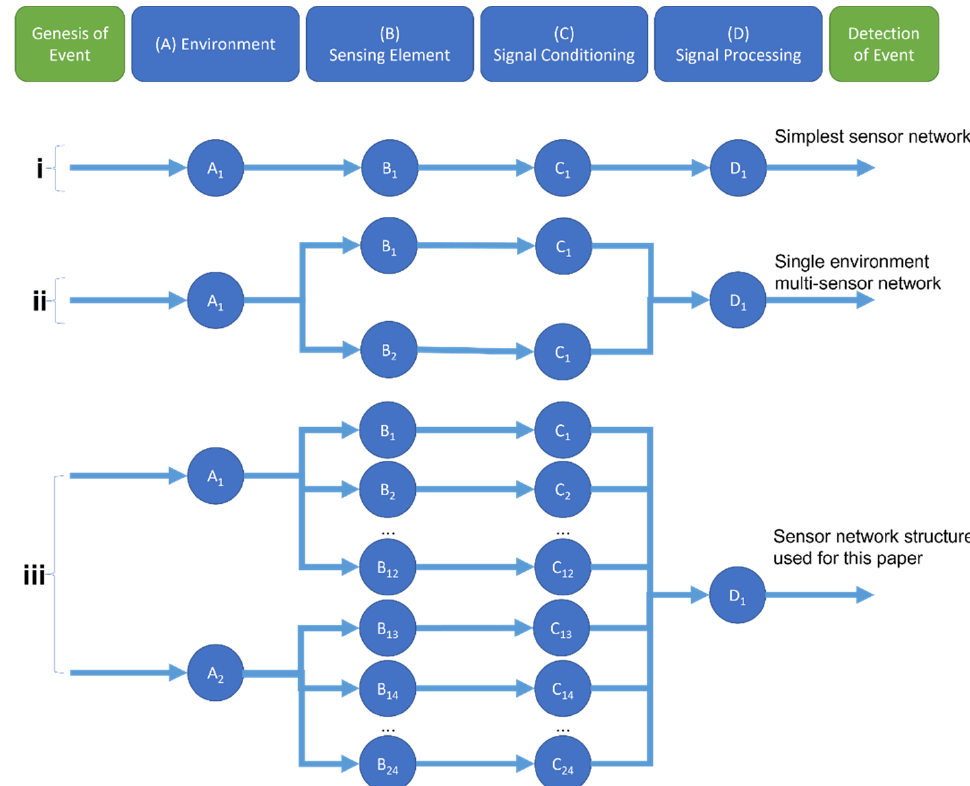
Figure 2. Model of a Probabilistic Sensor Network for event detection (adapted from [11]). The four steps that lead from the genesis of a given event up to its detection are shown at the top of the figure. ( i ) shows the simplest design, with only one node at each stage. ( ii ) shows a more complex network, featuring two sensors sharing the same sensing environment, each with their own conditioning step. ( iii ) displays the network used in this study, with two sensing environments (EMG and IMU sensing), each with 12 sensors, conditioned individually and combined together in the processing